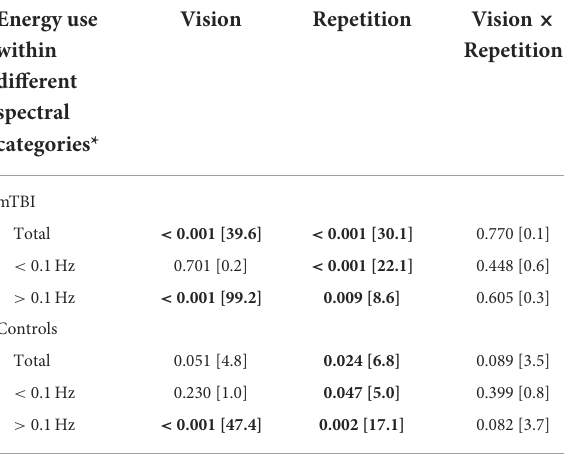
TABLE 2 GLM ANOVA analysis of effects of vision and repetition on group level on the stability during balance